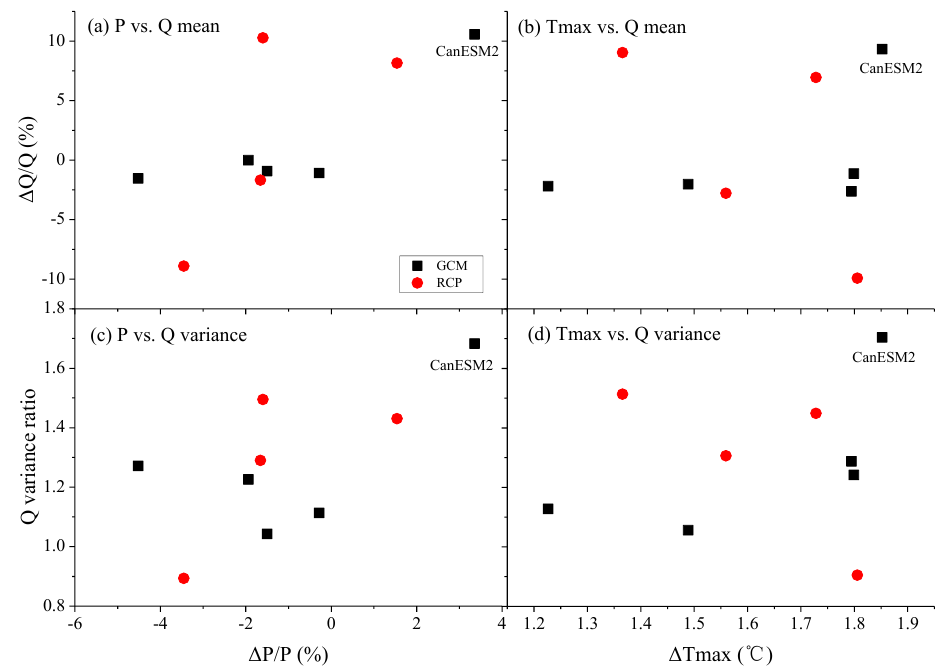
Figure 9. Projected changes ( (cid:49)) in precipitation ( P ), maximum temperature ( T max ) , and streamflow ( Q ) averaged over the ESMs or the